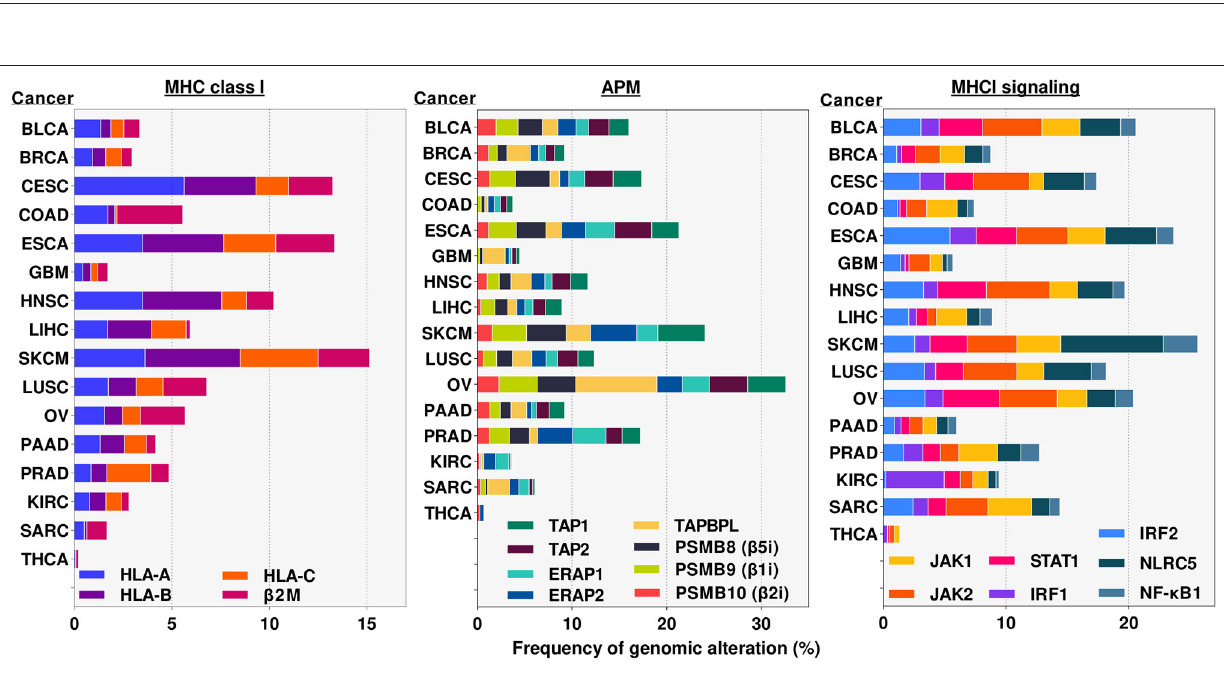
FIGURE 6 | Frequency of alterations in genomic sequences of MHC class I pathway genes in various cancers. Genomic alterations include any mutation, deletion and/or amplification occurring in either intron or exon regions of the indicated genes. Results were obtained from cBioportal.org (169, 170). analyses of publicly available TCGA data sets for the indicated genes and cancers. APM, Antigen Presentation Machinery. Cancer abbreviation are as in Figure 4 .